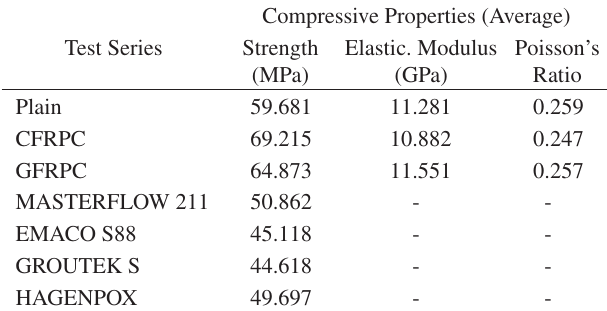
Table 3. Compressive Properties of Plain, Fiber Reinforced Polymer Concrete and Commercial Concretes.